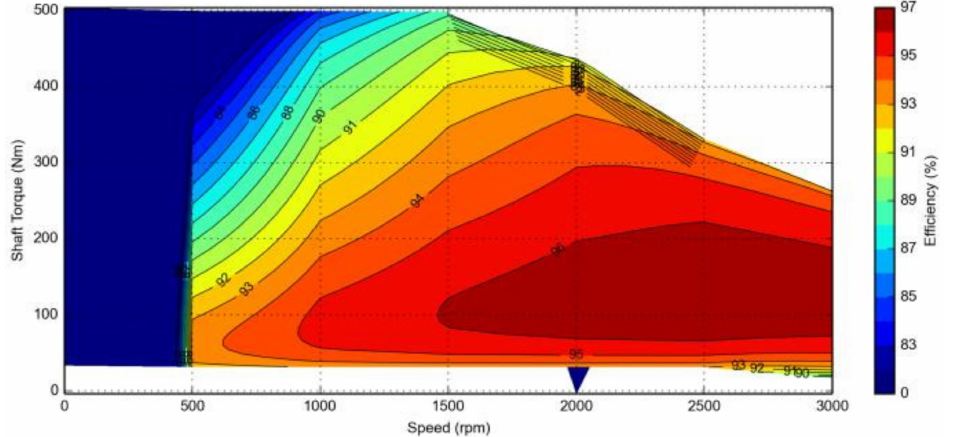
Figure 5. Efficiency map of